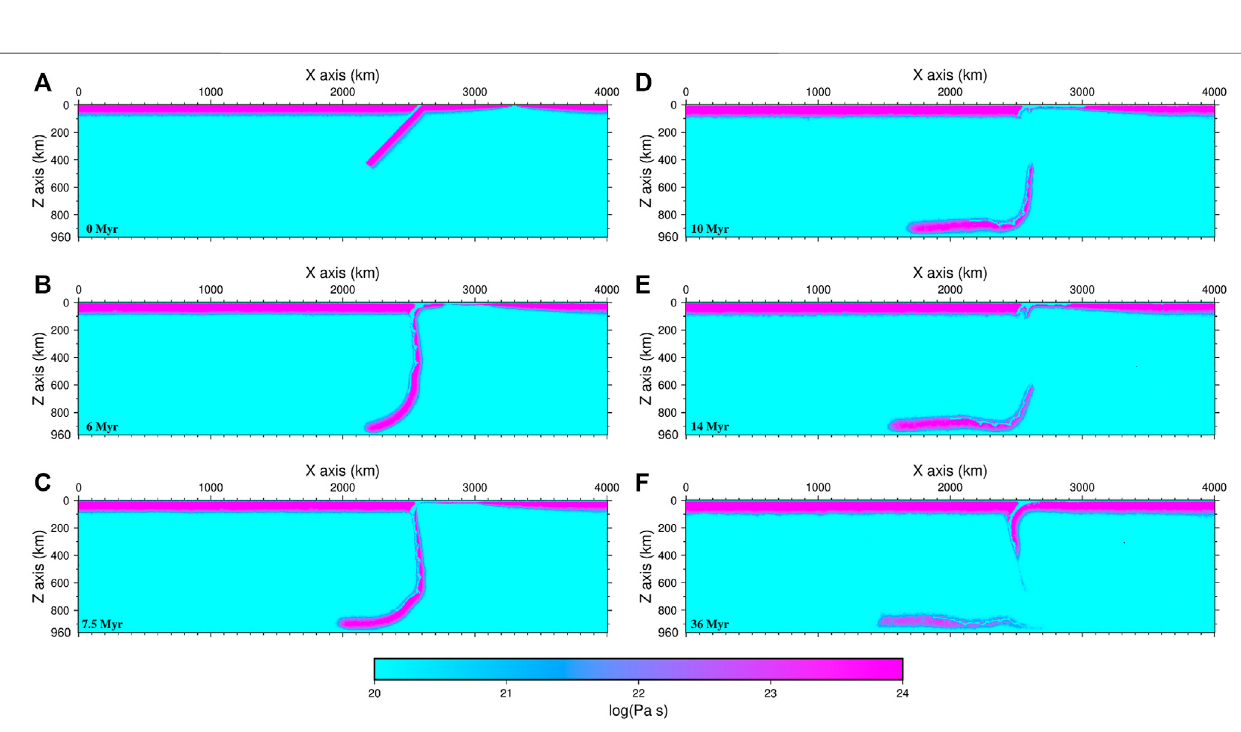
Frontiers in Earth Science |